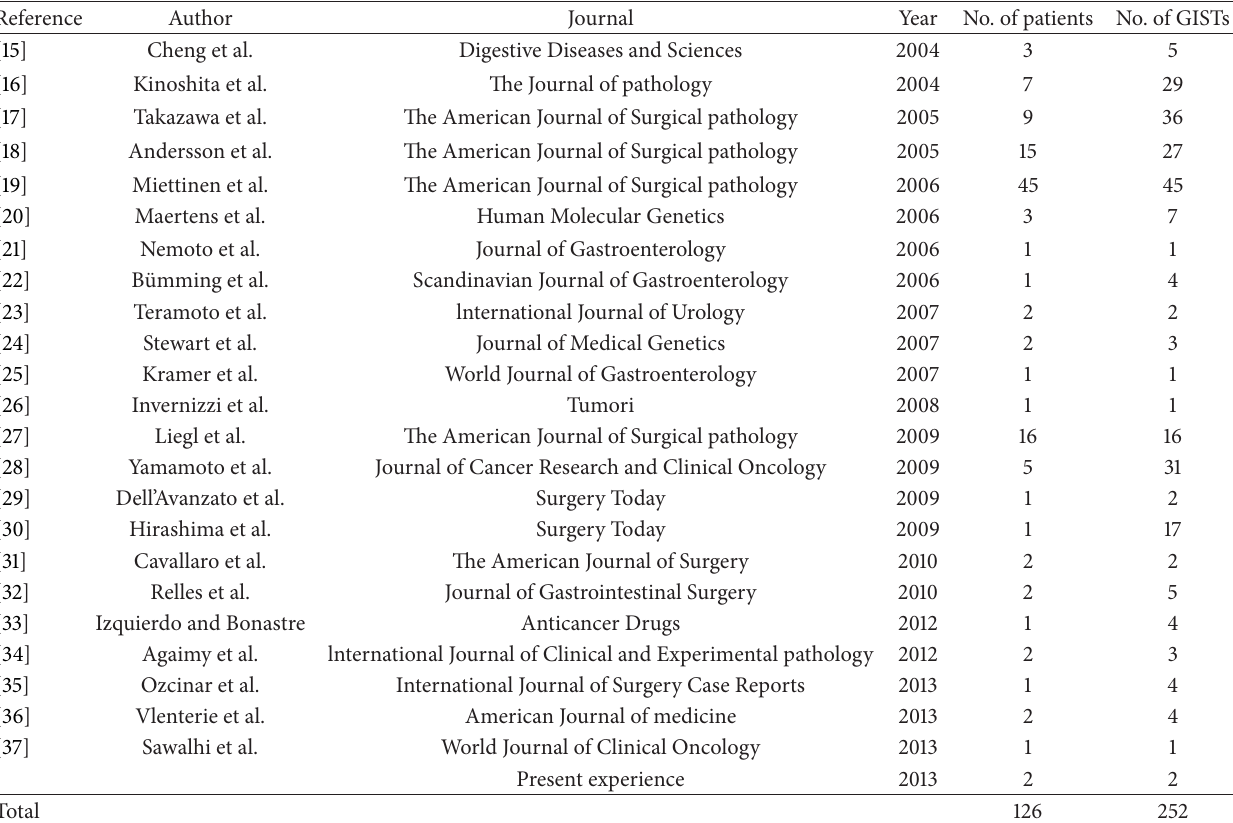
Table 1: Systematic review of the literature from 2004 to